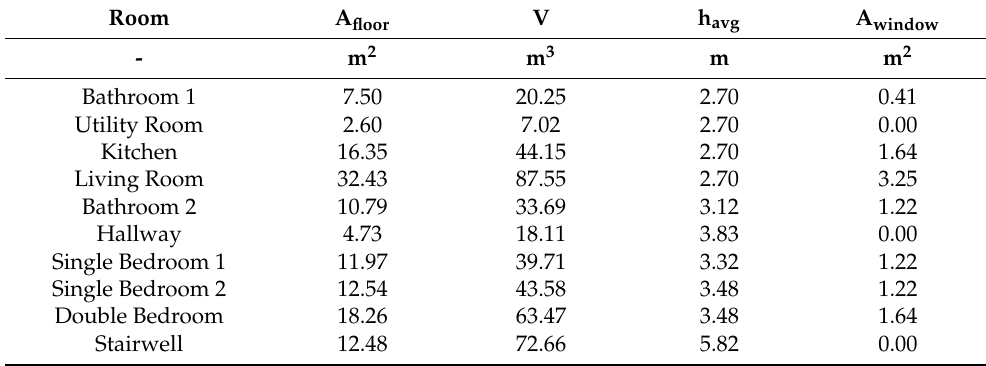
Table 2. Geometrical characteristics of thermal zones.